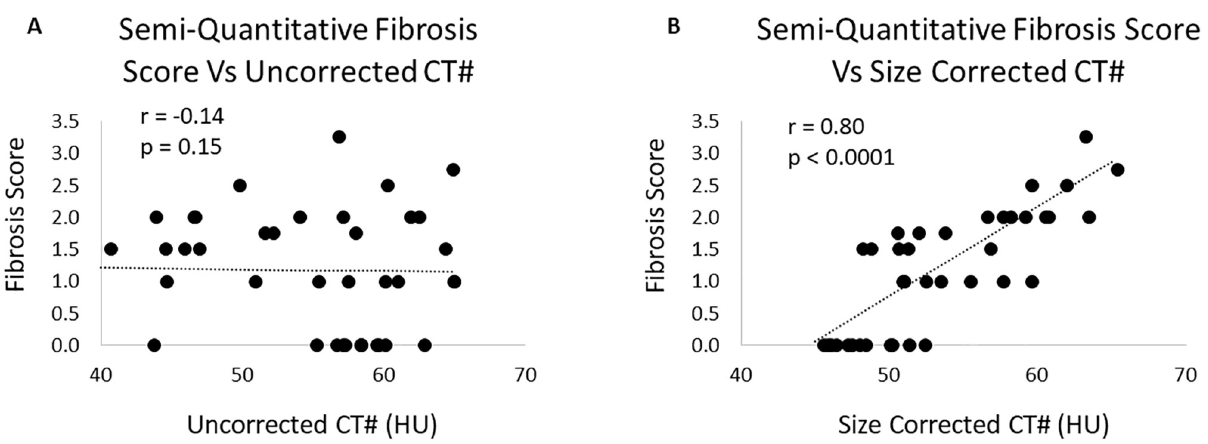
Fig 7. Effect of size adjustment on the correlation of CT HU to tissue fibrosis score. A) The correlation between histology fibrosis scores and uncorrected CT number is obscured by the dependence of CT number on subject size. B) When the CT number is corrected for subject size using the total CT total signal index, there is a strong correlation between histology fibrosis score and CT number.